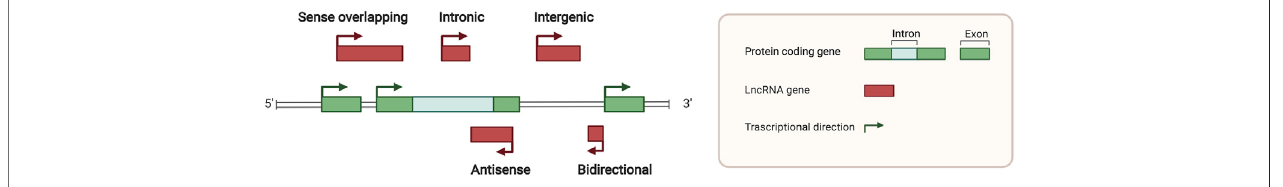
FIGURE2 | Locationsoflong noncodingRNAs in thegenome. Green squares indicate protein coding genesin thegenome, while red squares indicate noncoding RNA transcripts. Sense overlapping, antisense, intronic, intergenic, and bidirectional lncRNA loci was classi fi ed by different relative locations with protein coding genes.